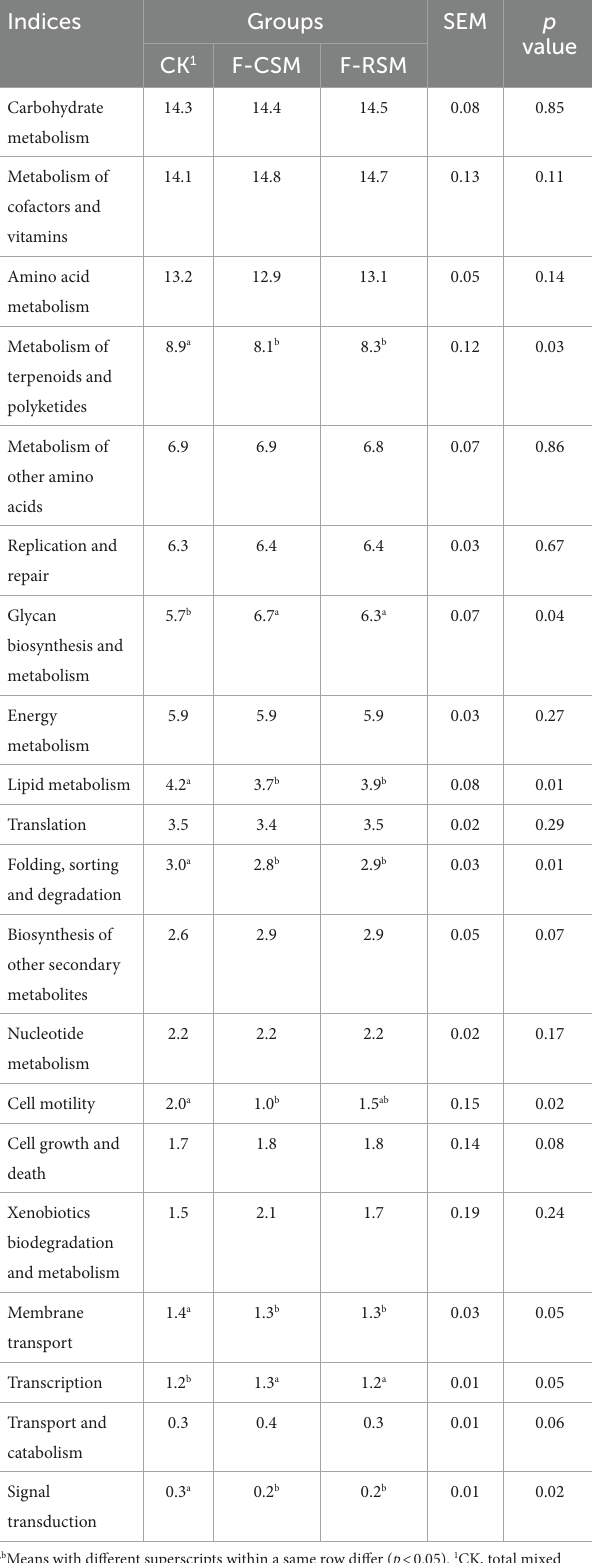
TABLE 5 Effect of feeding different diets on predominant predicted gene pathways in the different ruminal ecological niches of growing Hu sheep. Indices